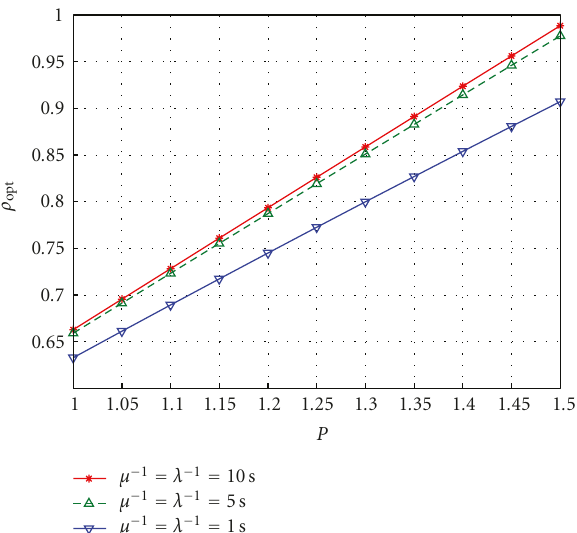
ff erent holding